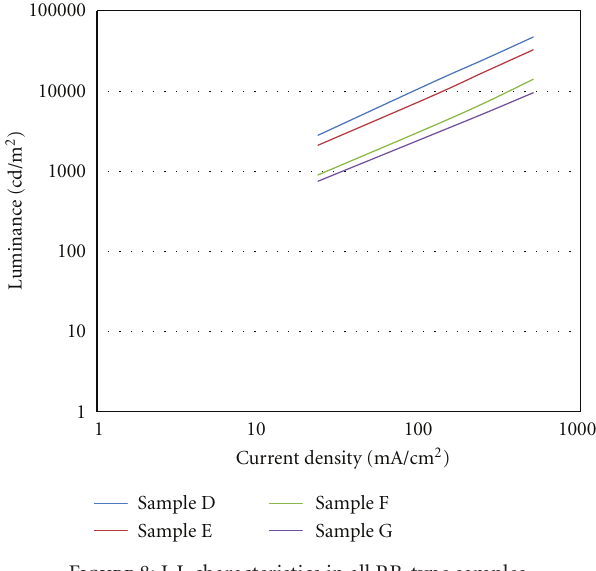
Figure 8: J-L characteristics in all RB-type samples.